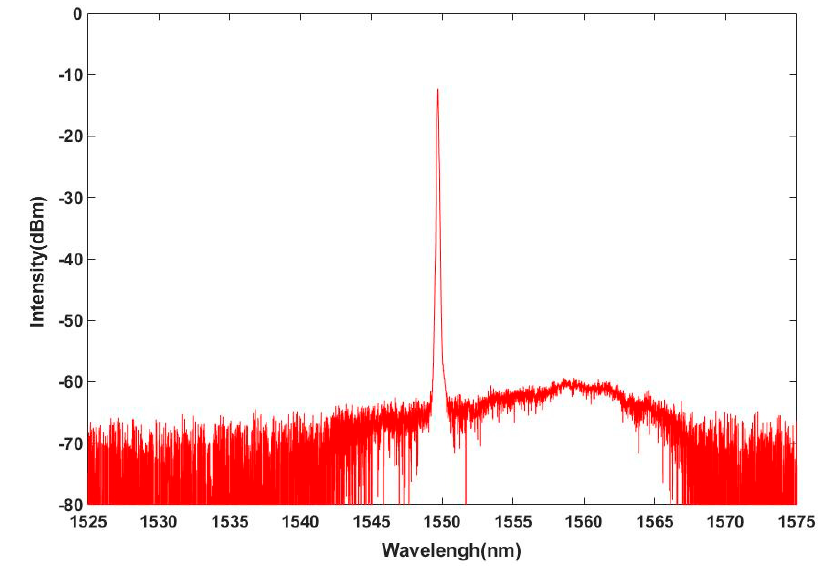
Figure 4. Output spectrum of the second preamplifier.